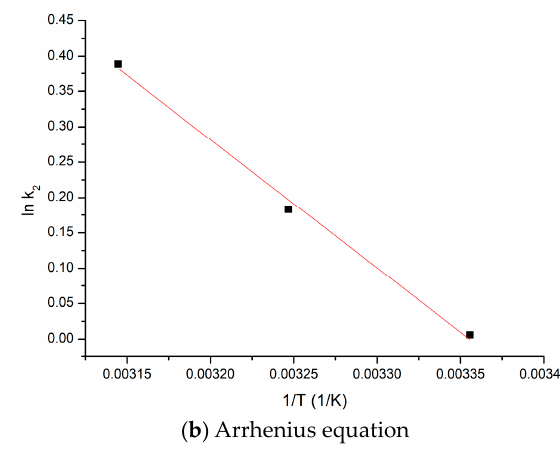
Figure 11. Thermodynamic studies.